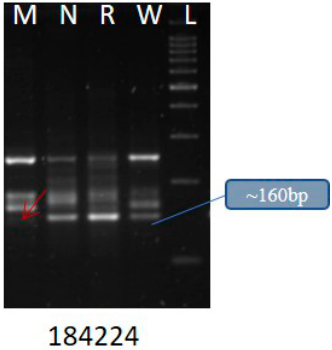
Figure 2. Representative SSR showing polymorphism among the natural. populations of YSB from four different locations: Medak (M), Nizamabad (N), Rajendranagar (R), and Warangal (W) of Telangana state.